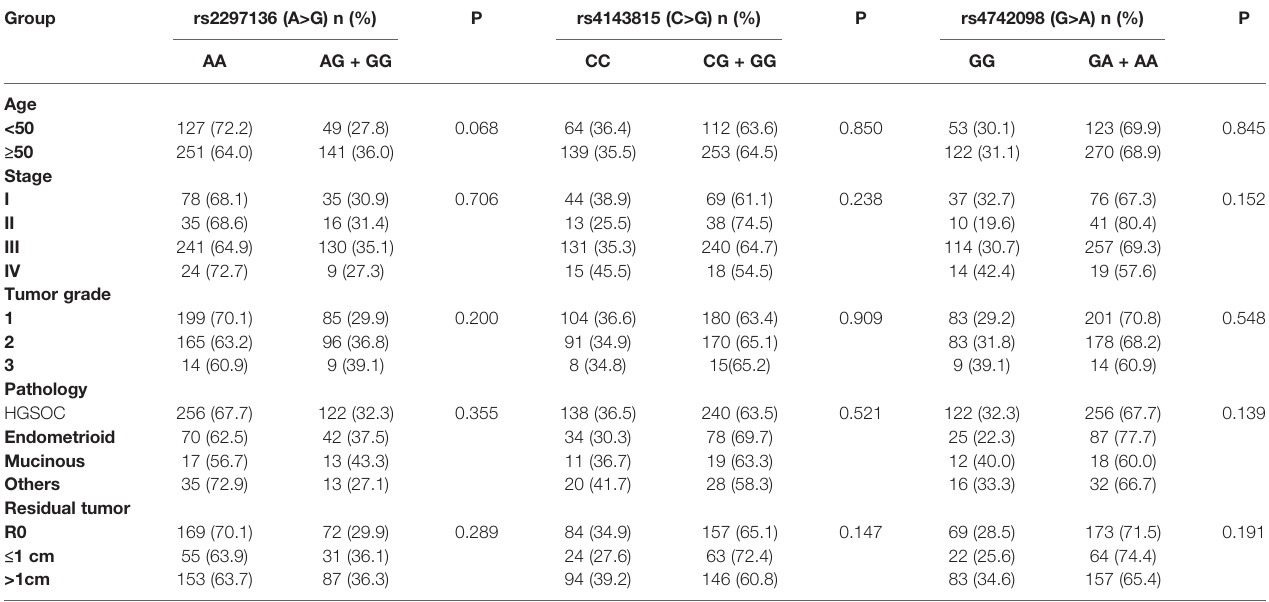
TABLE 2 | The association between PD-L1 polymorphisms and clinical characteristics of EOC patients. Group